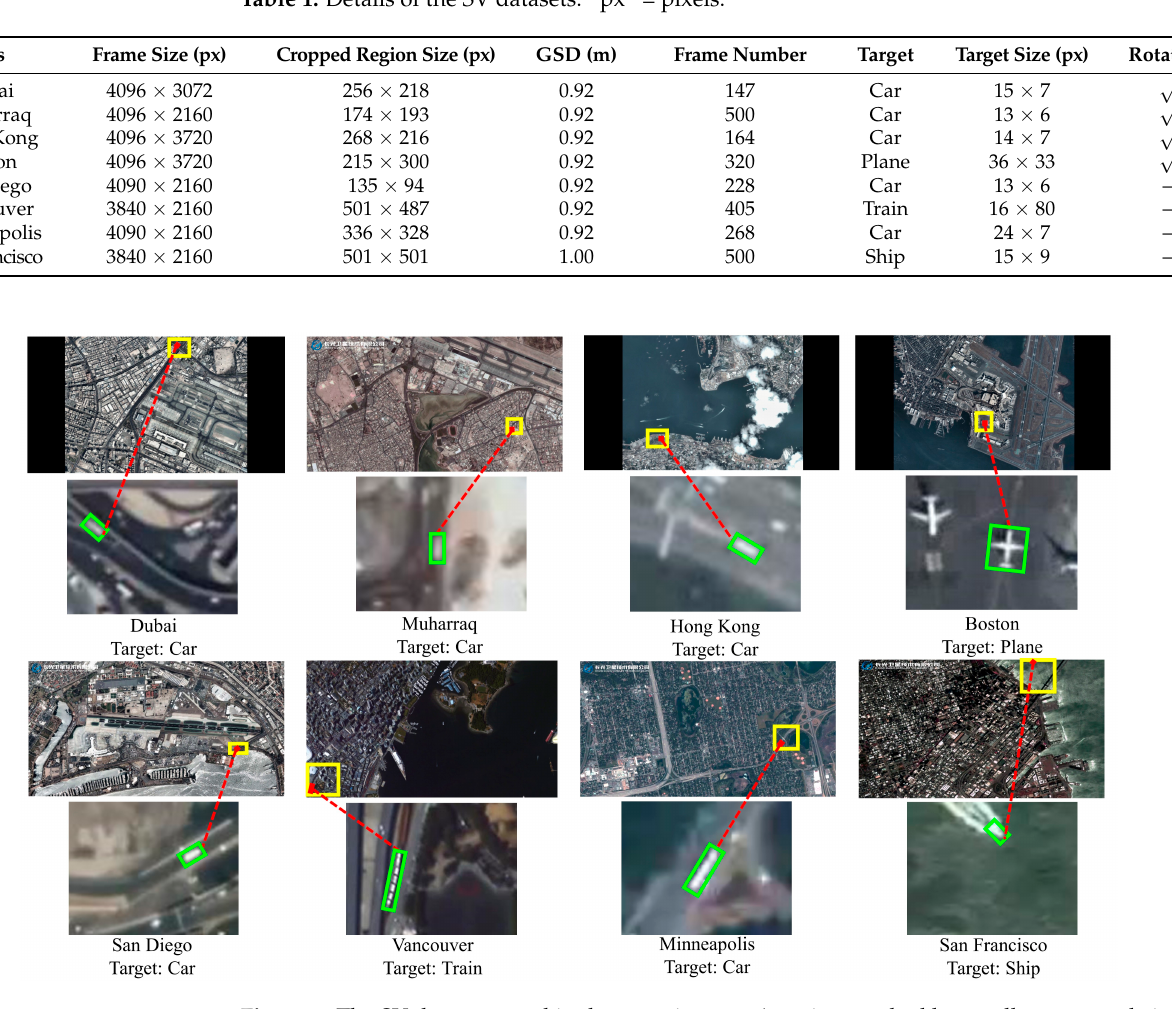
Table 1. Details of the SV datasets. “px” = pixels.